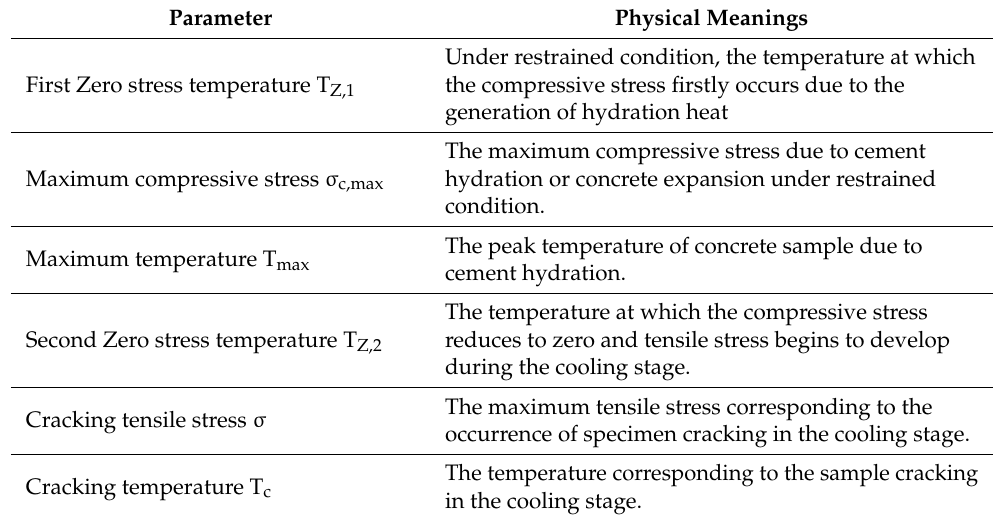
Table 4. Temperature parameters from TSTM test and their concepts specified in Standard